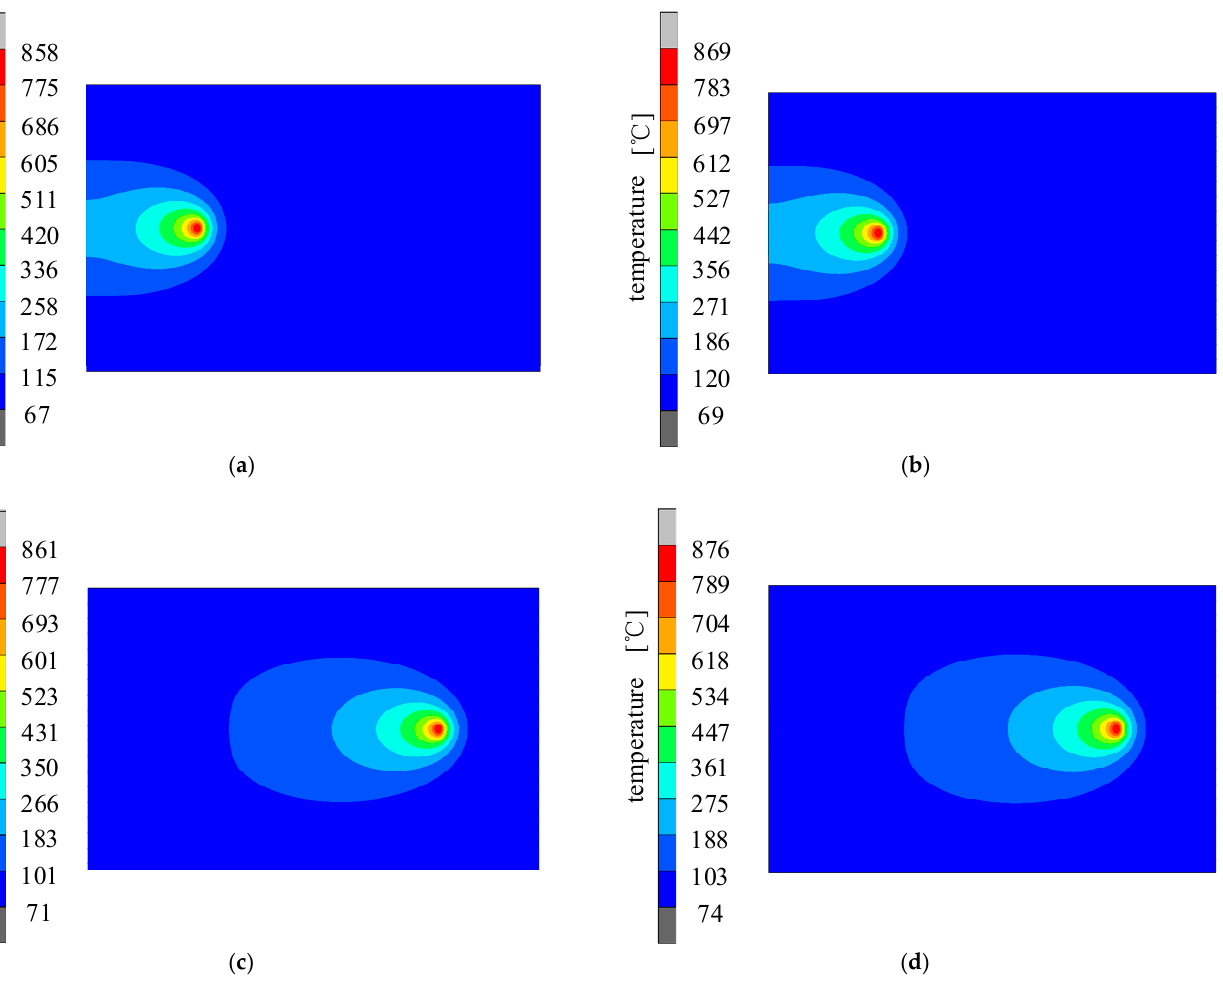
Figure 5. Contours of the temperature field distribution under different conditions: ( a ) under high- speed gas fluid conditions at t = 20 s; ( b ) under conventional welding conditions at t = 20 s; ( c ) under a high-speed gas fluid condition at t = 60 s; ( d ) under conventional welding conditions at t = 60 s.